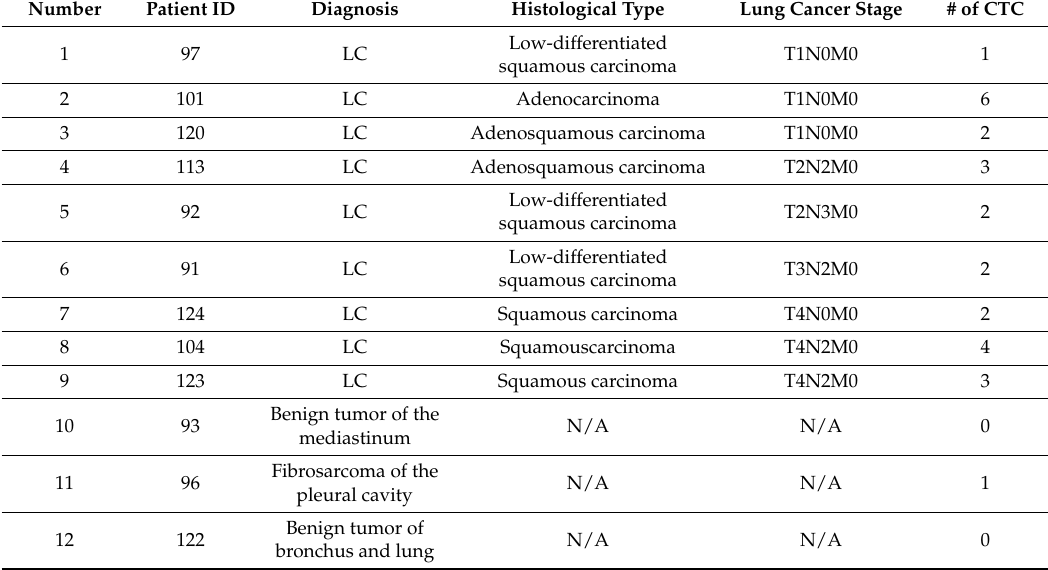
Figure 6. Aptamer-facilitated isolation of circulating tumor cells (CTCs). CTCs were isolated from the blood of two LC patients: ID#101 (A1–A3) and ID#113 (B1–B3, C1–C3), using biotinylated aptamers EPCAM-APT-01 and EPCAM-APT-02 and then stained with the same fluorescent aptamers. Table 4. Amounts of CTCs isolated from the blood (3.5 mL) of LC patients and patients with non-malignant diseases of the lung using aptamers EPCAM-APT-01 and EPCAM-APT-02.